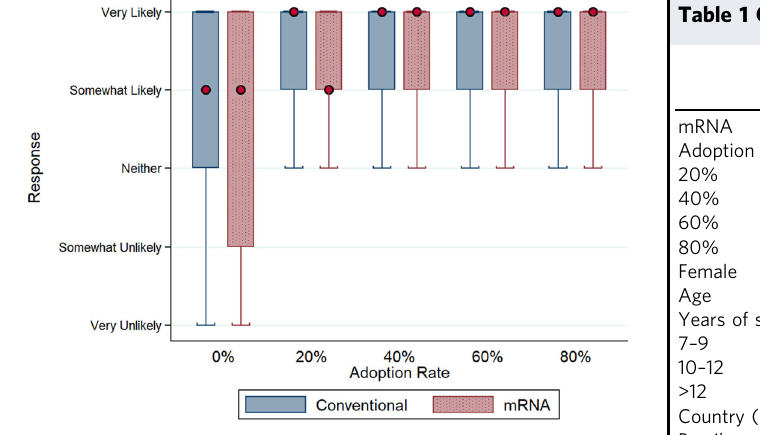
Fig. 2 The distribution (box and whisker plots) of responses, by vaccine type and adoption rate, to the question “ Suppose the [conventional/ RNA] Covid-19 vaccine is endorsed by your Government, free, [but no one/and 20%/and 40%/and 60%/and 80% of people] in your country [has/have] received the vaccine. How likely are you to accept the vaccination? ” Boxes indicate median and interquartile range (IQR) with the red dot specifying median value, and whiskers indicate range (data within 1.5*IQR). Conventional vaccine n = 17,527 responses (0% adoption rate n = 3,488 responses, 20% n = 3,551 responses, 40% n = 3,620 responses,